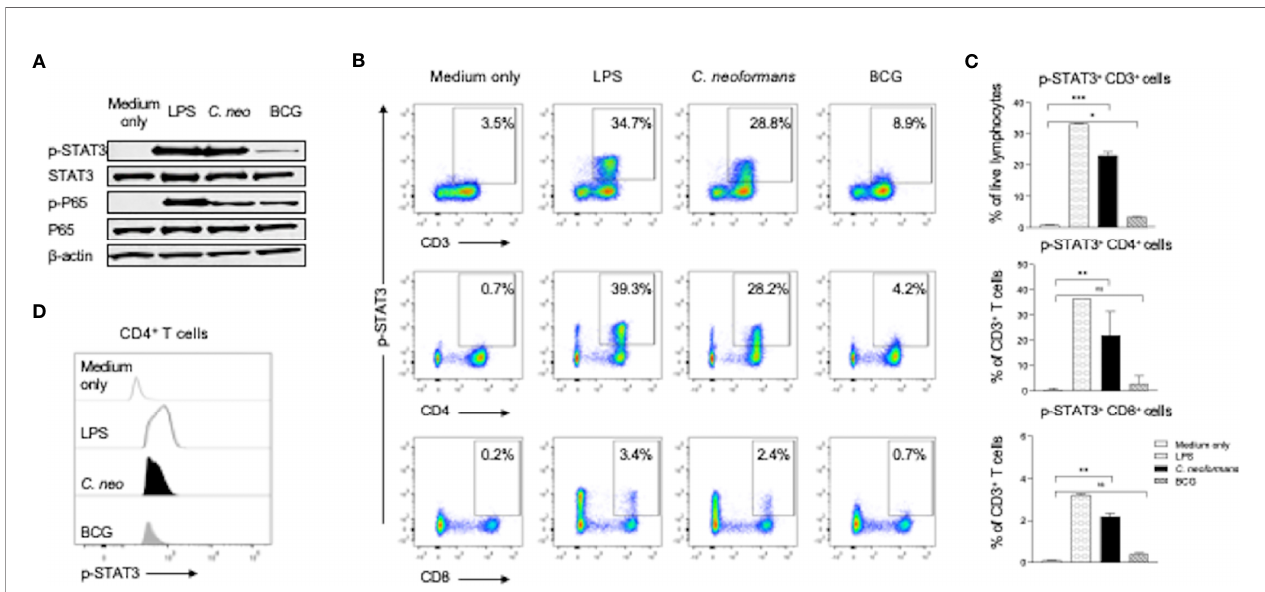
FIGURE 4 | C. neoformans stimulates the phosphorylation of STAT3 in CD4 + T cells. Peripheral blood mononuclear cells were stimulated for 30 min with lipopolysaccharide (100 ng/ml), C. neoformans , or BCG. The phosphorylation status of STAT3 and its downstream P65 at the protein level were analyzed by western blot (A) . Phosphorylation of STAT3 in T cell subsets (B, C) , and its fl uorescence intensity was analyzed by fl ow cytometry (D) . Representative data of three individual experiments are shown. *0.01<p<0.05, **0.001<p<0.01,